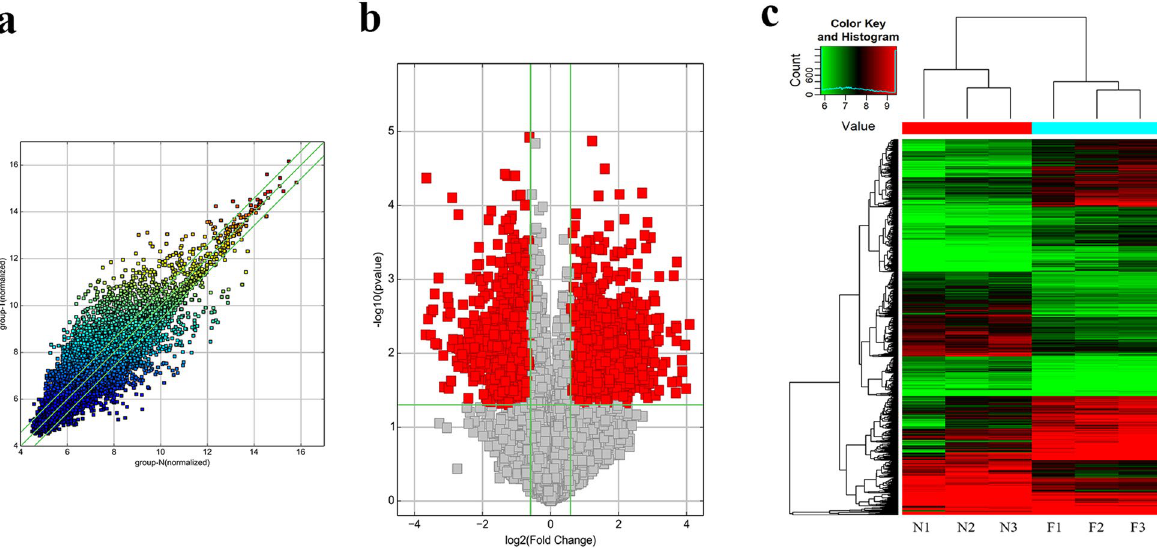
Figure 1. The expression profiles of circRNAs compared between β-thalassemia carriers with high HbF and healthy controls. ( a ) Scatter plot showing the distribution of circRNA expression. ( b ) Volcano plots showing differential expression of circRNAs. ( c ) Clustergram showing the entire circRNA expression profiling of the samples.